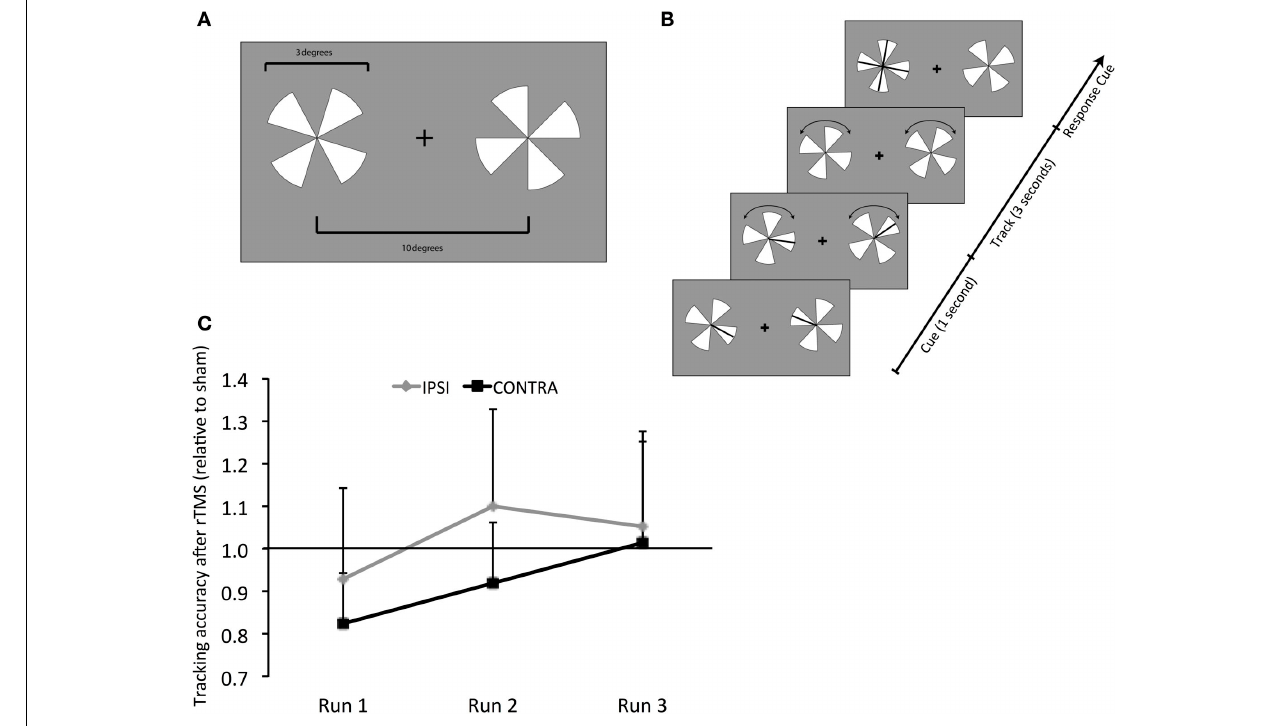
FIGURE 1 | Behavioral Task - Design and Results. (A) Visual tracking task. Stimuli were high-contrast pairs of pinwheels displayed on either side of a central fixation cross. (B) At the start, the targets (a randomly selected spoke on each pinwheel) were cued briefly. Following the cues disappearance, the pinwheels rotated at a fixed rate, determined by individual subjects’ threshold for 85% correct performance, while subjects tracked the targets. After 3s, both pinwheels stopped and were aligned so that all probes on the target